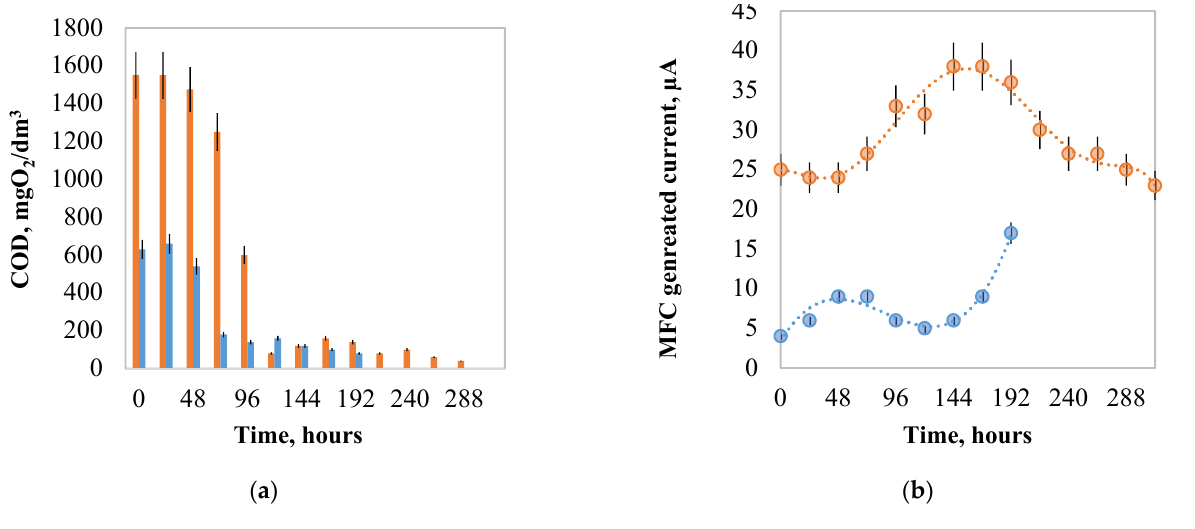
Figure 4. Utilization of wastewater (with high organic load—orange, low organic load—blue) in MFC–COD removal ( a ) and electric current generated ( b ).